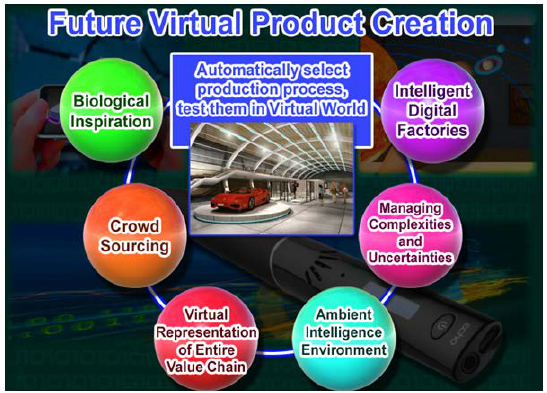
Figure 9. Components of future virtual product